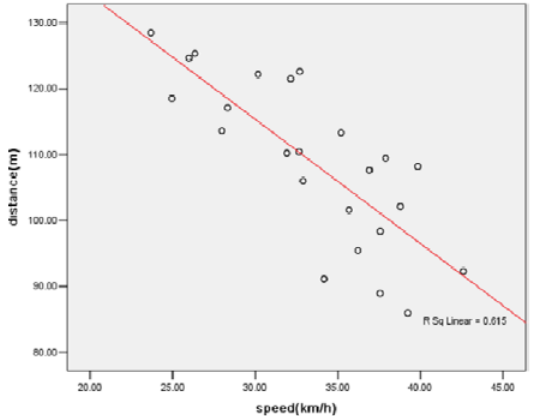
Fig.6. Speed and legibility distance relationship in field experiment